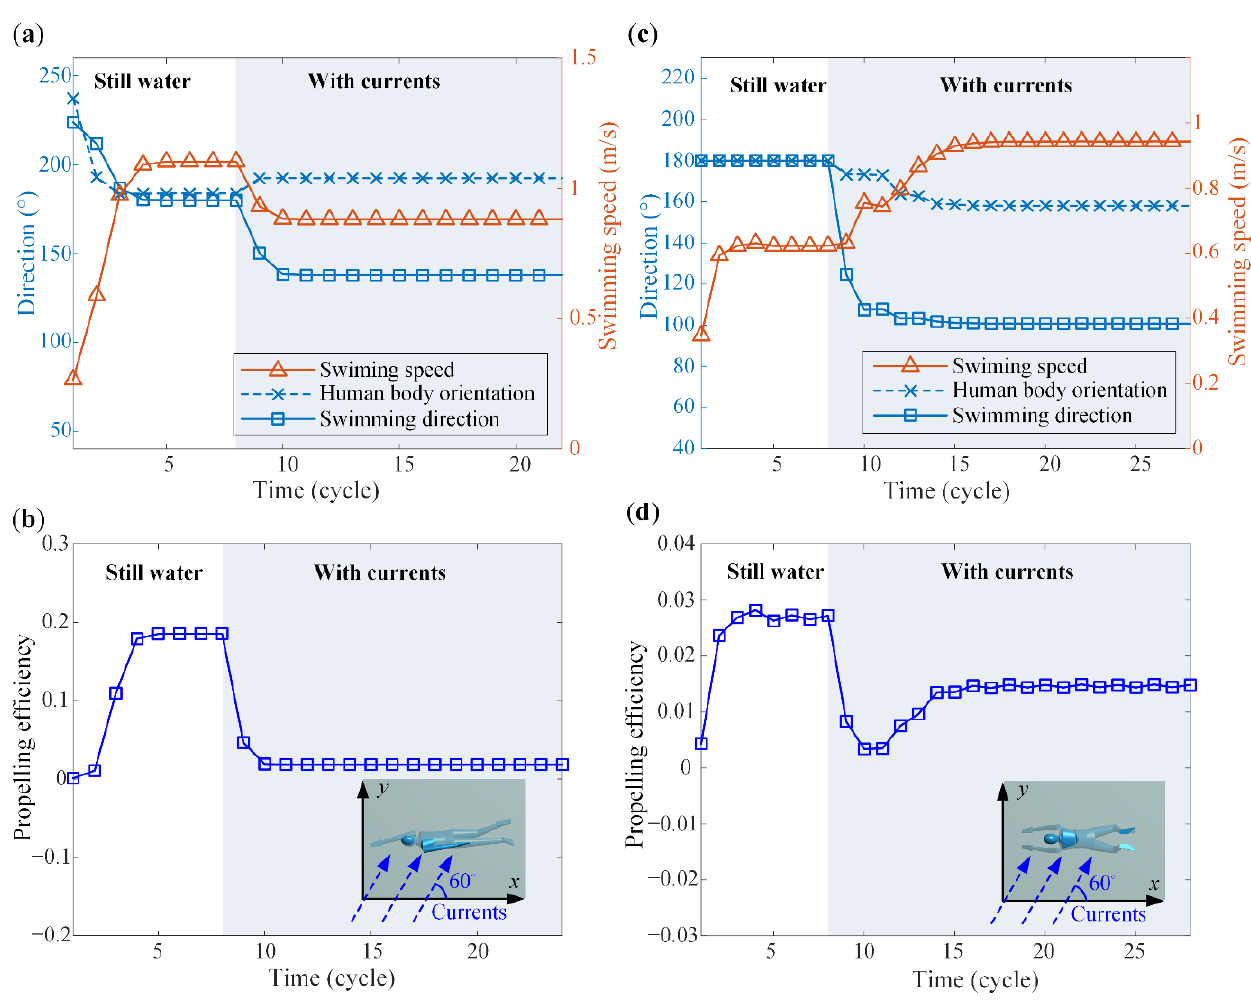
Figure 4. Time histories of the swimming speed, swimming direction, human body orientation, and propulsive efficiency. The currents are applied after the 8th cycle, the current direction is 60 ° , and the current velocity is 1 height/cycle. ( a , b ) show the freestyle swimming; ( c , d ) show the breaststroke swimming.